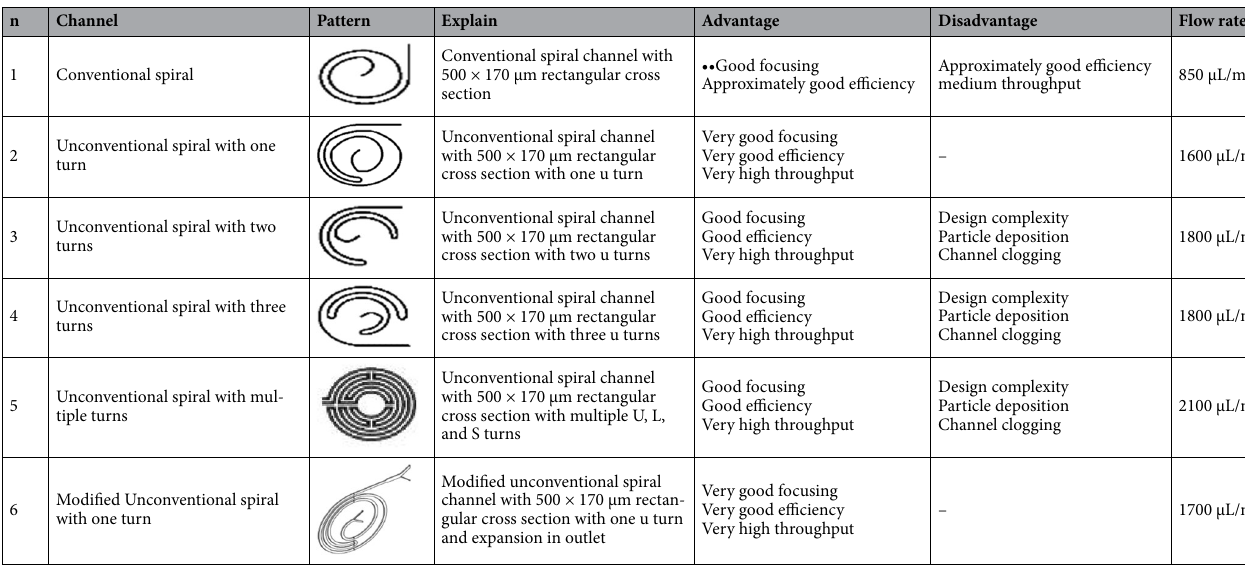
Table 3. Summary of simulation results along with schematic of their geometric